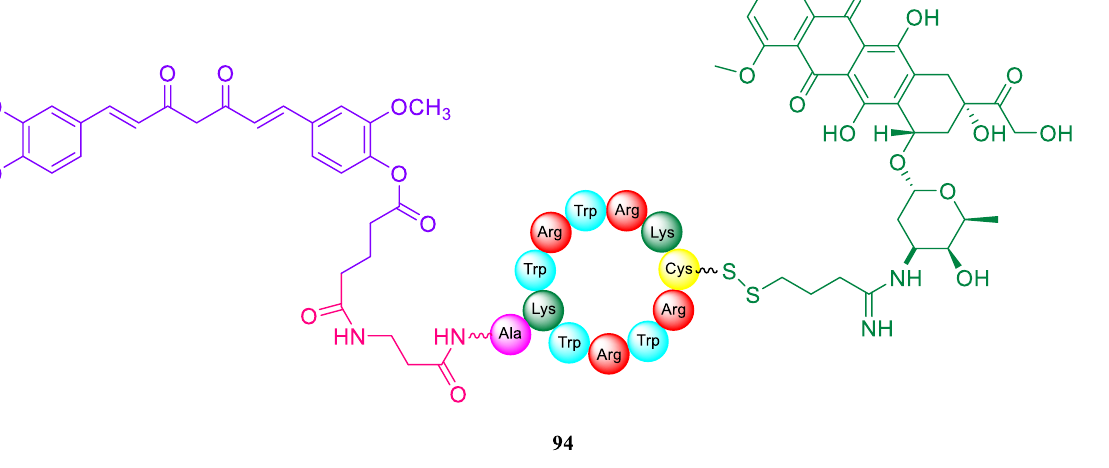
Figure 76. Doxorubicin-curcumin conjugated to cyclic peptide analogues.